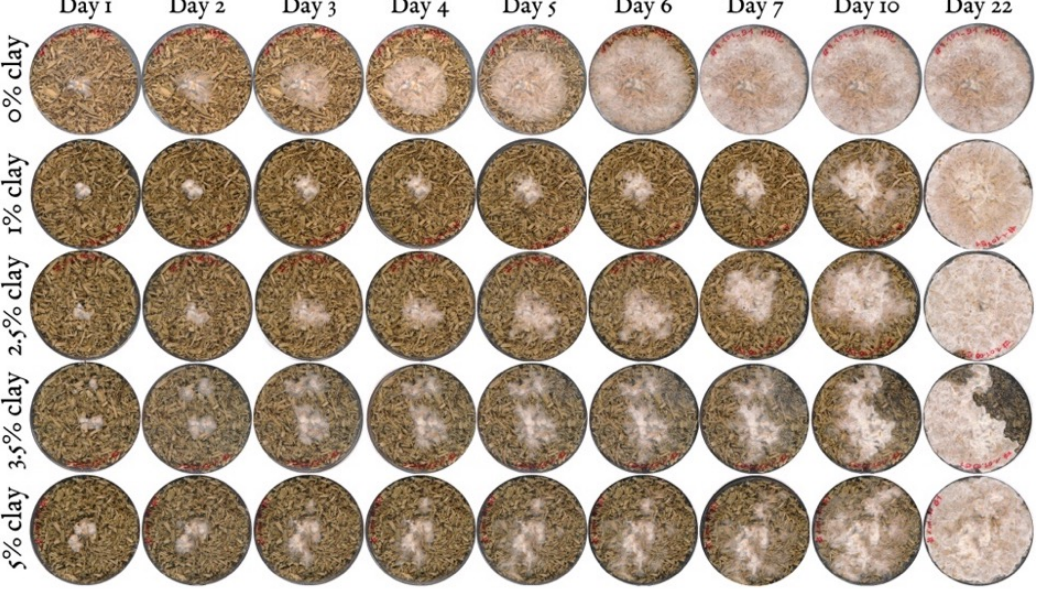
Figure 4. Colonization over 22 days for T. versicolor (M9912) on a hemp and 0–5% nanoclay